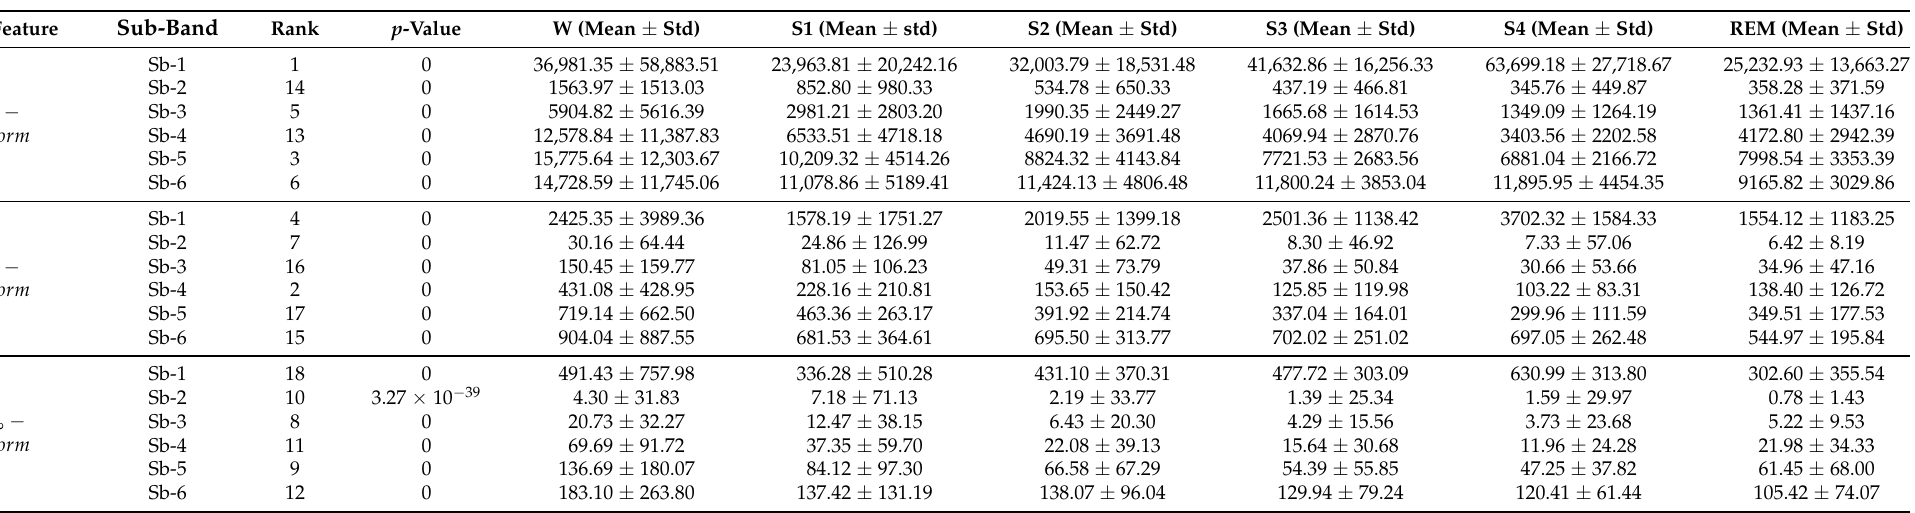
Table 6. Statistical analysis using ANOVA for C4-A1